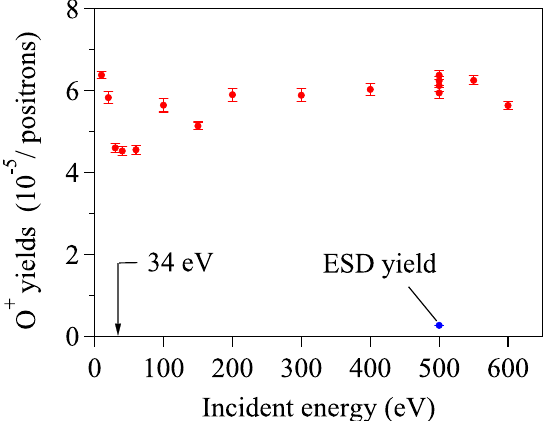
Figure 2. Desorption yields of O + ions from a TiO 2 (110) surface as a function of incident positron energy. The arrow indicates the initial ESD threshold of 34 eV. The ESD yield of O + ions by a 500-eV electron beam is also plotted and